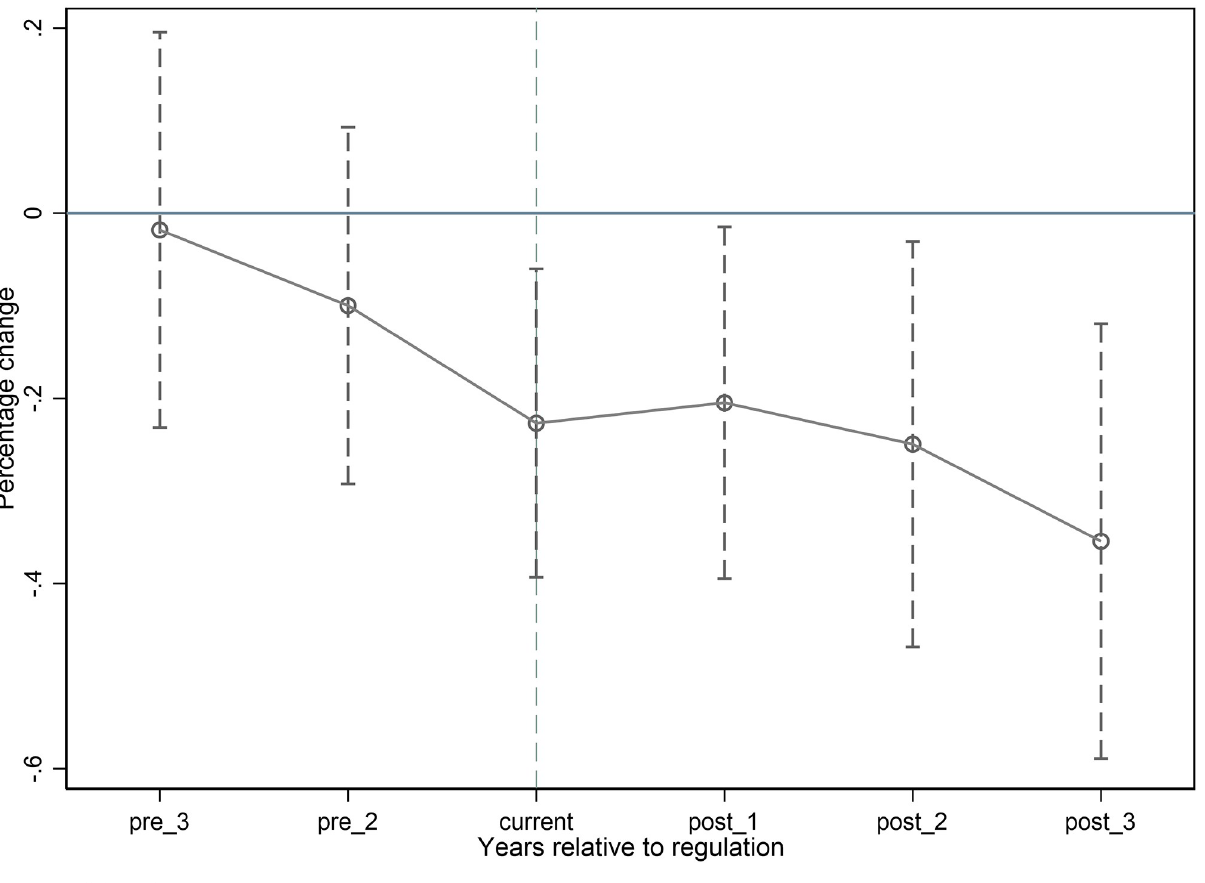
Fig 1. Parallel trend